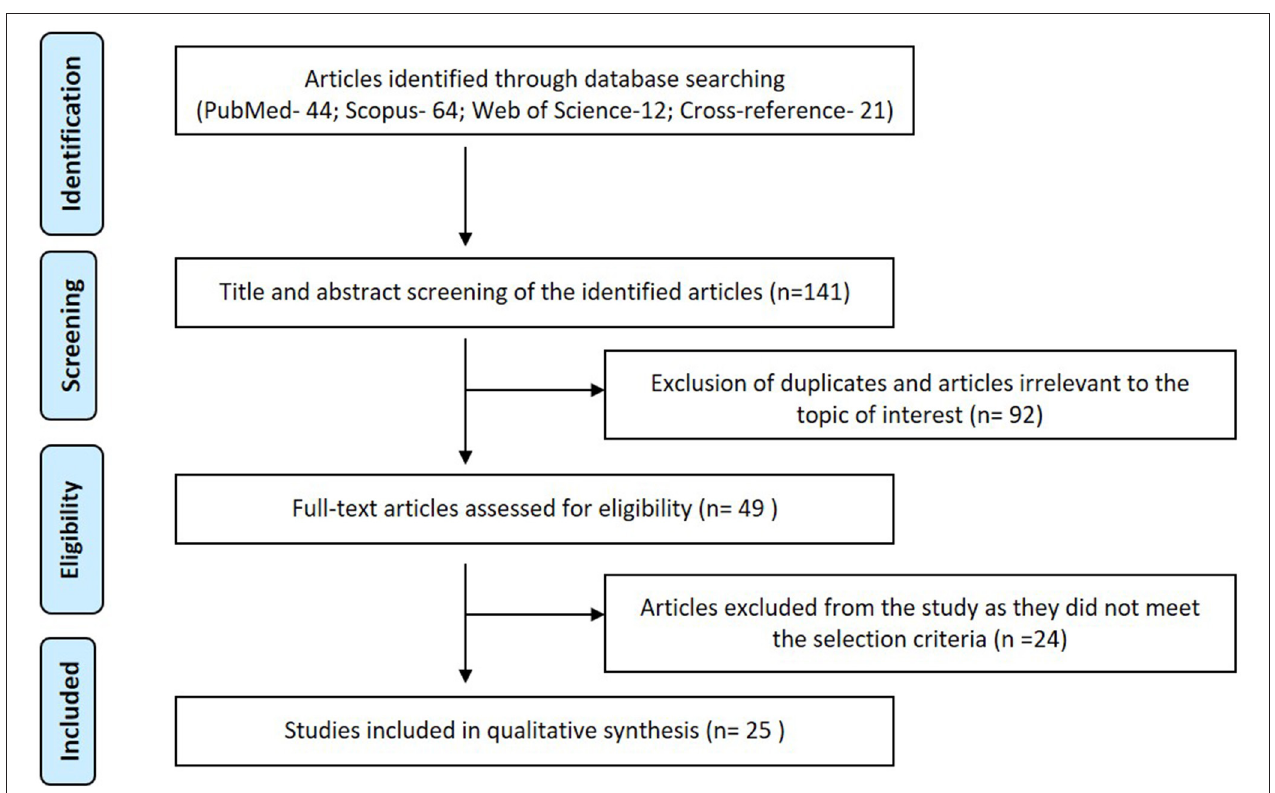
FIGURE 1 | PRISMA flow diagram summarizing the study